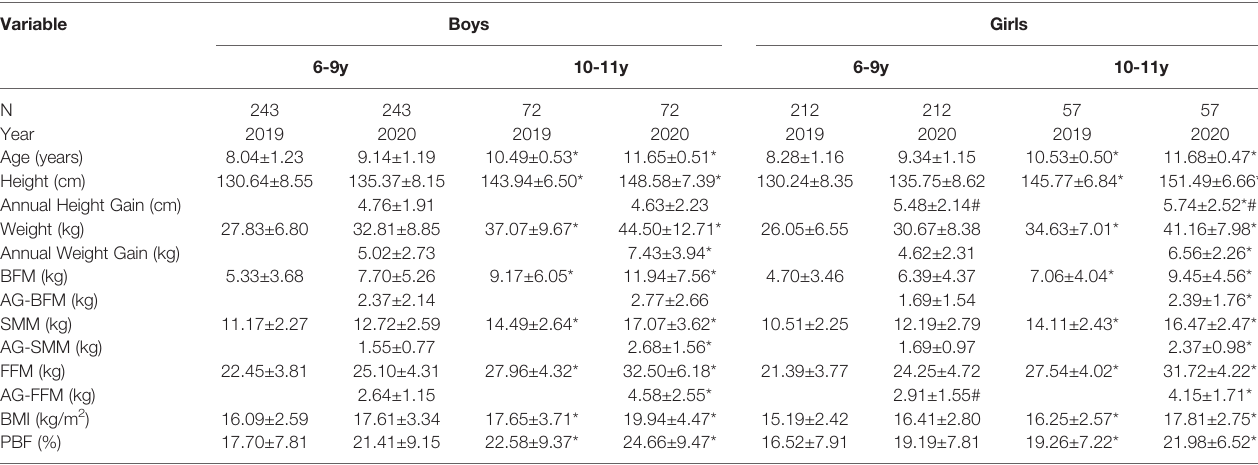
TABLE 1 | Anthropometric and body composition characteristics of participants by sex and age. Values = mean ± SD.